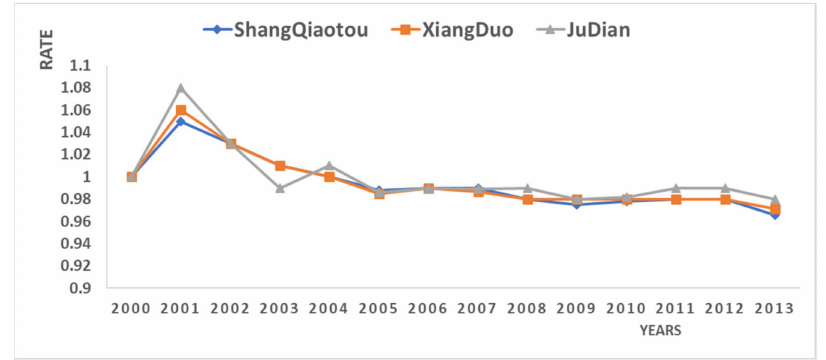
Figure 7. Annual average rate of change of groundwater level in the area of the Three Parallel